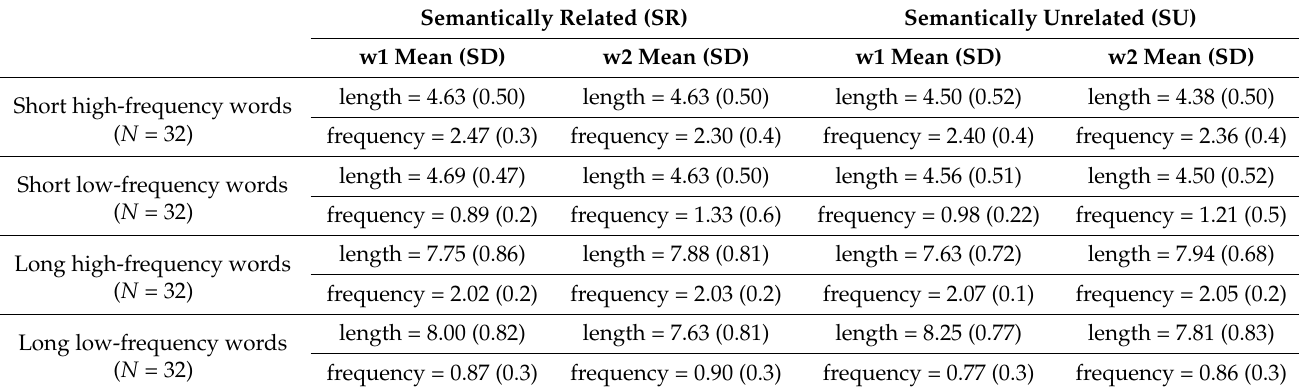
Table 1. Mean values and standard deviations (in brackets) for the stimuli. Semantically Related